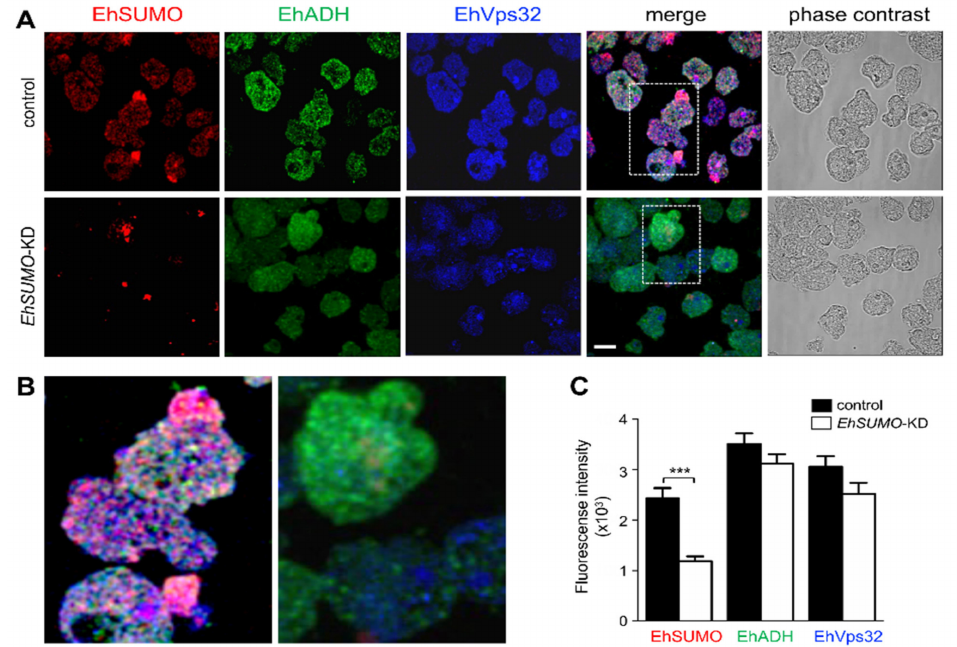
Figure 12. Localization of EhSUMO, EhADH, and EhVps32 in EhSUMO -KD trophozoites in basal conditions. Confocal microscopy of control and KD trophozoites in basal conditions. ( A ) Representative image of control and EhSUMO -KD tropho- zoites using α -EhSUMO (red), α -EhADH (green), and α -EhVps32 (blue) antibodies. Scale bar = 10 µ m. ( B ) Magnification of squares in (A). ( C ) Fluorescence intensity measured by pixels and corresponding to EhSUMO, EhADH, and EhVps32 in both types of trophozoites. (***) p < 0.001.